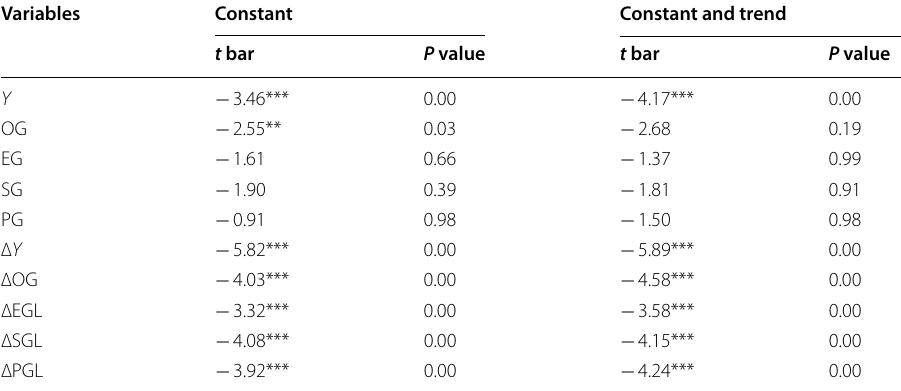
Table 2 Results of Pesaran’s CADF test